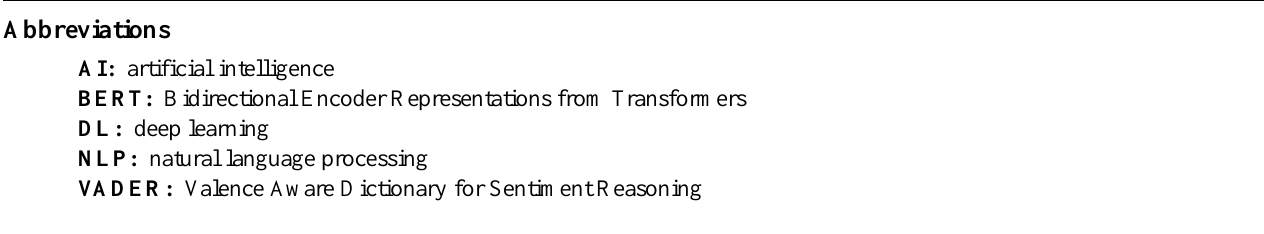
BERT: Bidirectional Encoder Representations from Transformers DL: deep learning NLP: natural language processing VADER: Valence Aware Dictionary for Sentiment